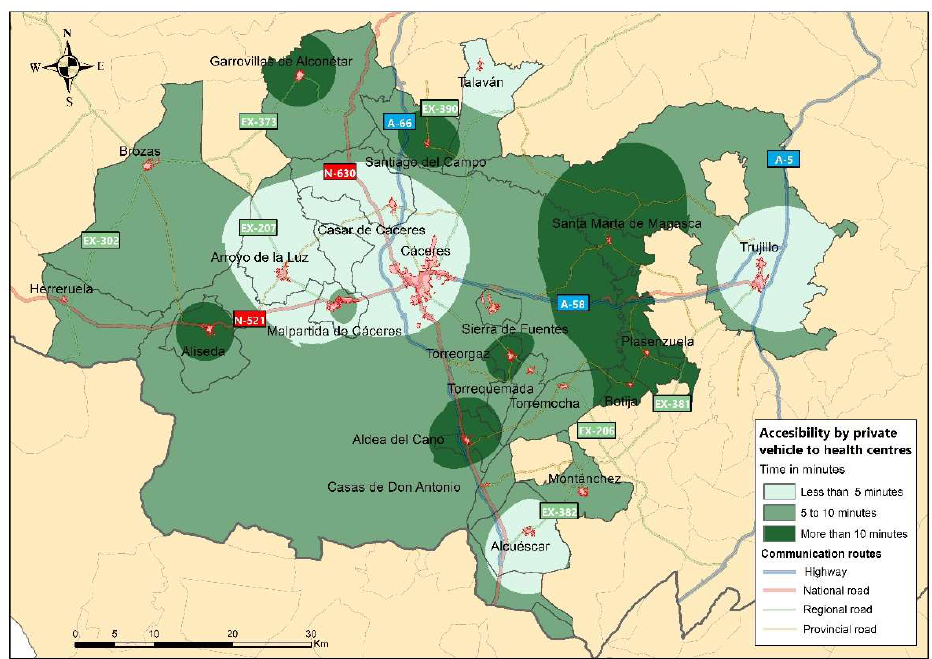
Figure 5. Territorial accessibility to health